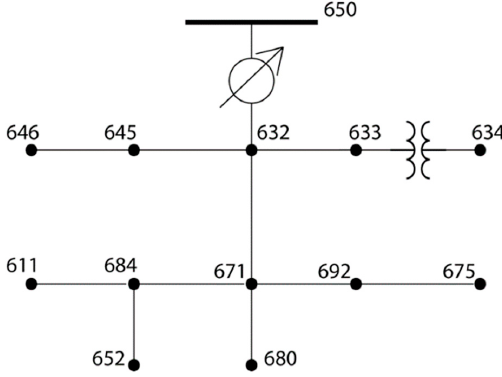
Figure 3. Single-Line Diagram of IEEE 13-bus feeder.